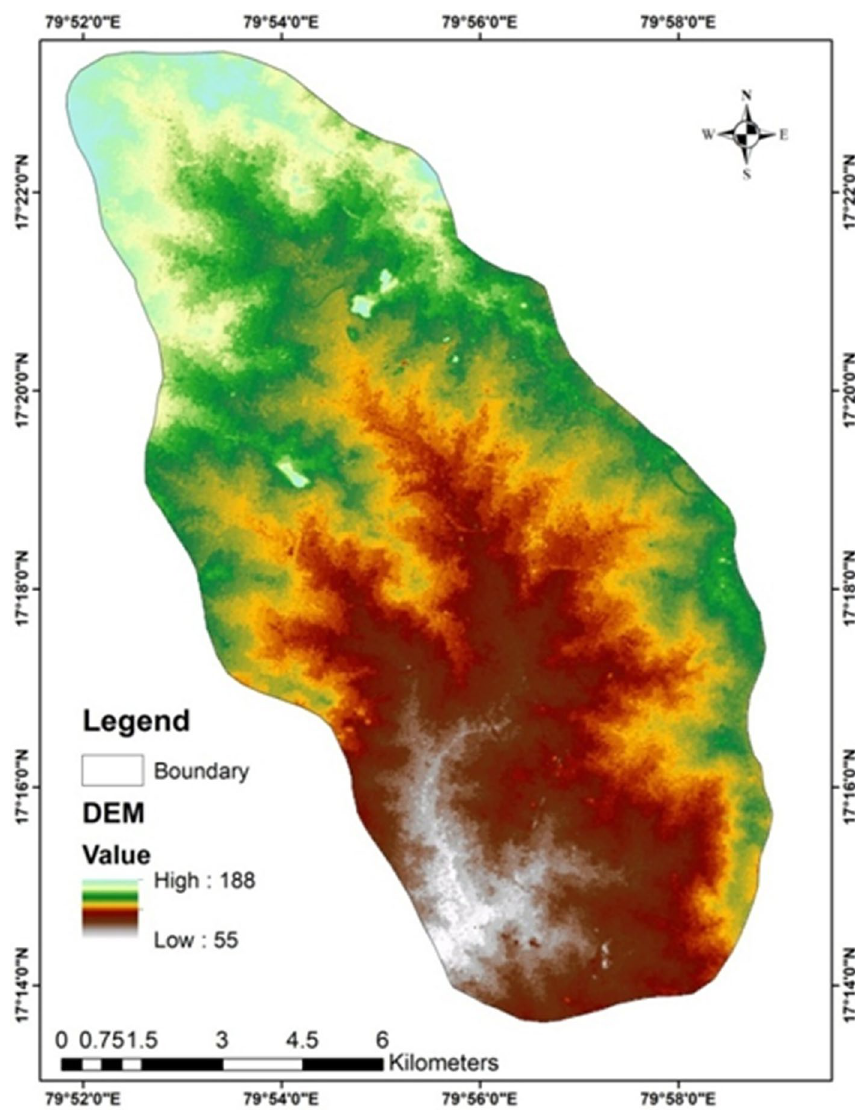
Fig. 3 Subledu basin digital elevation model